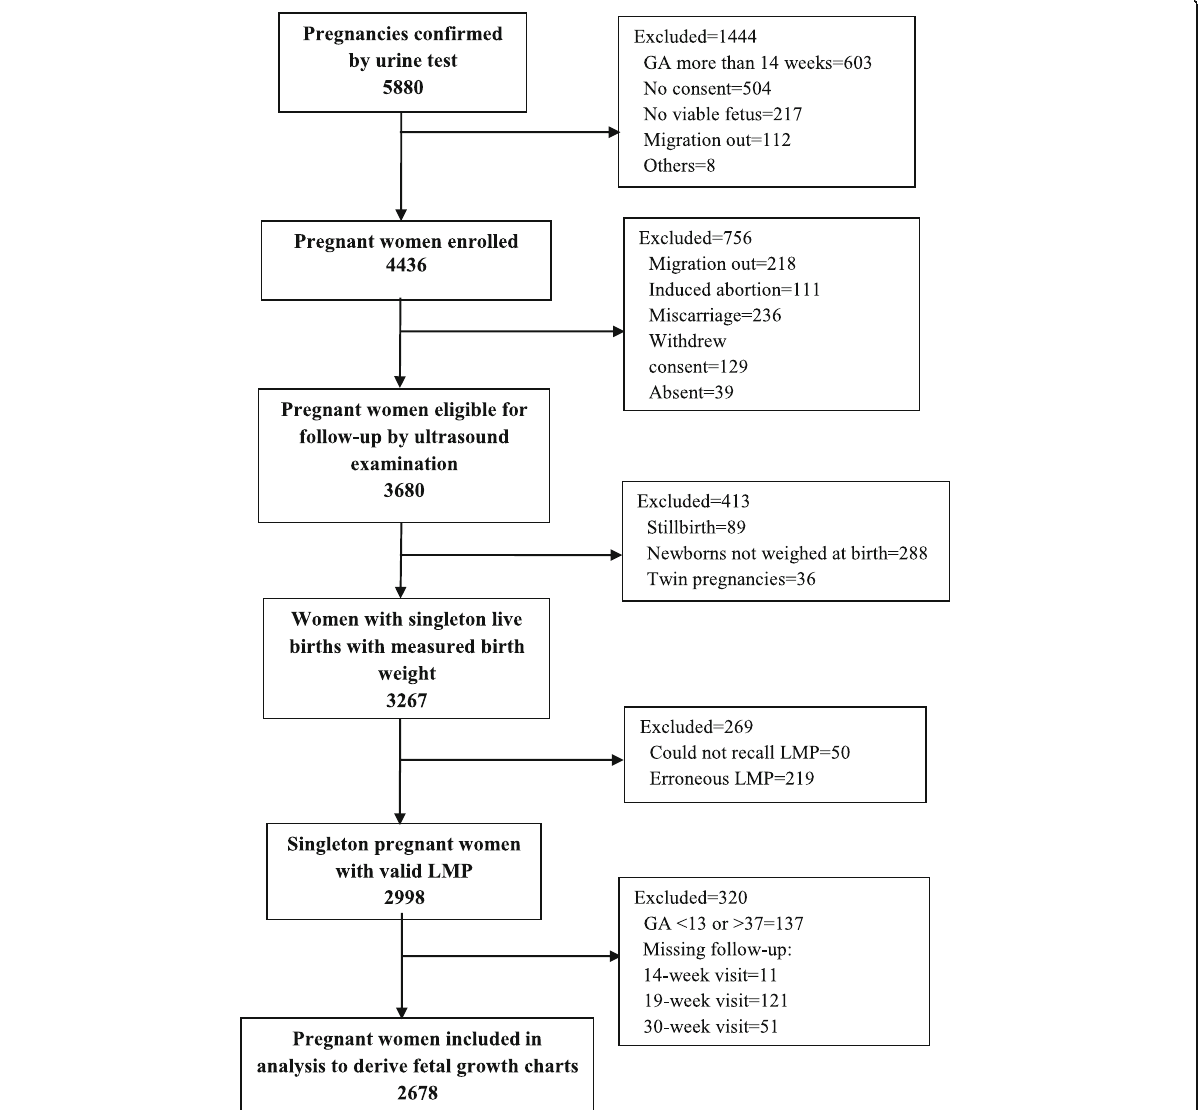
Fig. 1 Flow chart of study participants. Abbreviation: GA gestational age, LMP last menstrual